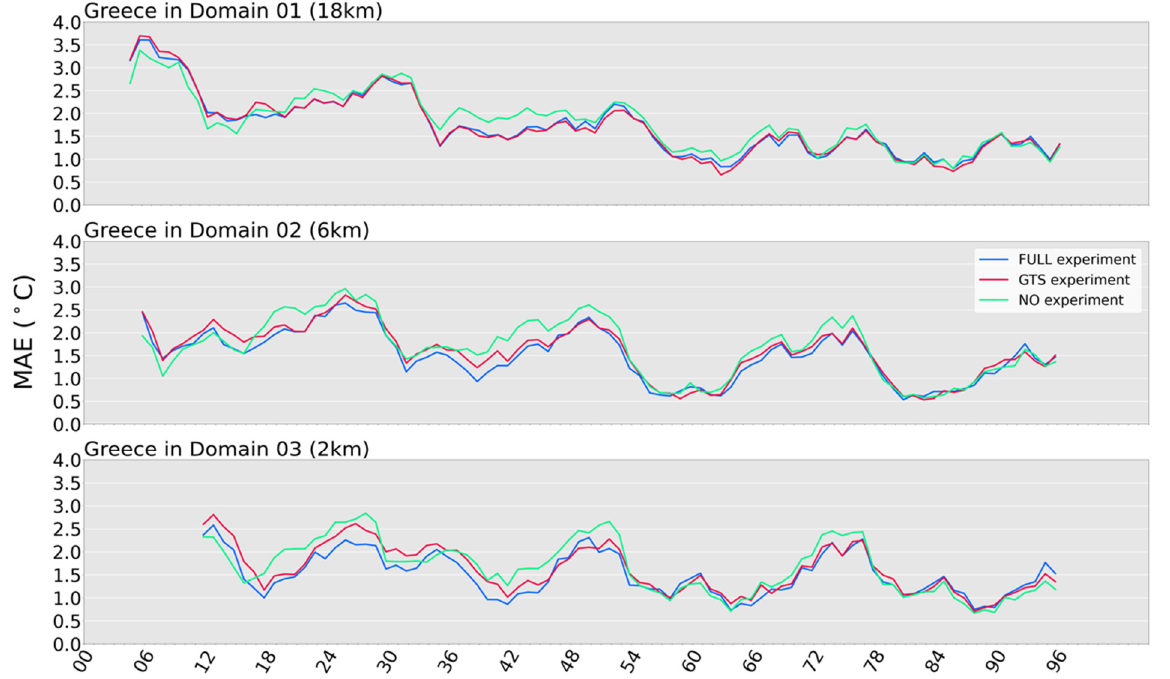
Figure 7. Hourly time series of 2 m temperature MAE for the area of Greece. Each panel refers to a specific spatial resolution domain and the scores achieved for each type of experiment (i.e., FULL, GTS, NO). The blue lines represent the FULL experiment, the GTS experiment is depicted in red, and the NO experiment is depicted in green.